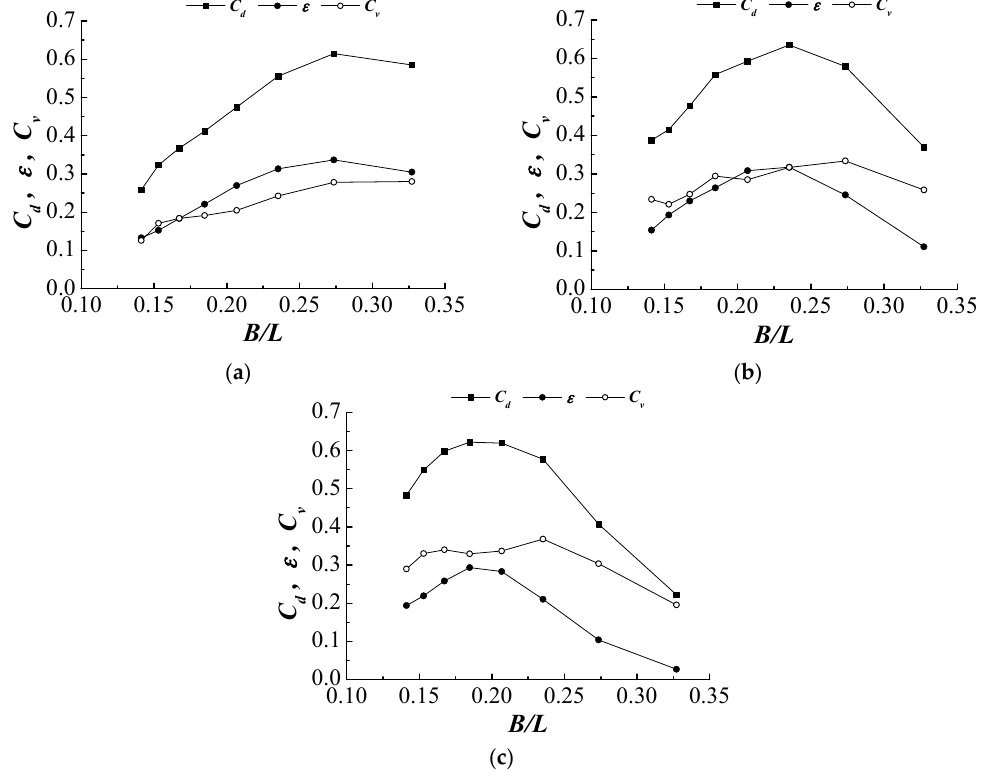
Figure 8. Variations of energy dissipation C d , energy efficiency ε and vortex-induced energy loss C v versus B / L for slot-shaped opening of 1.25% ratio with: ( a ) 10 cm draft; ( b ) 15 cm draft; and ( c ) 20 cm draft.